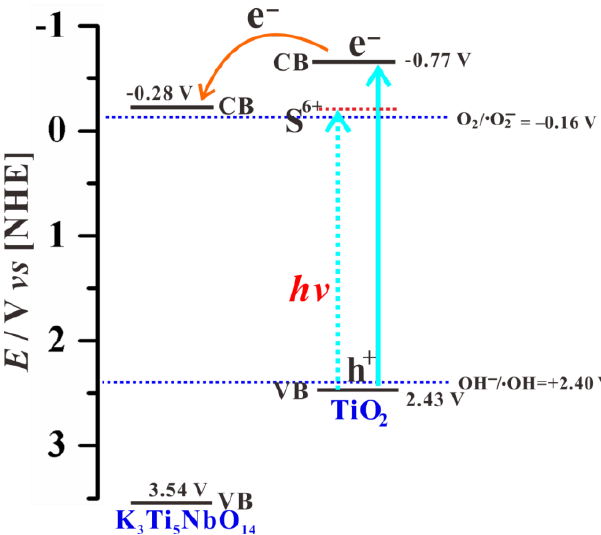
Figure 11. Energy levels of K 3 Ti 5 NbO 14 and anatase TiO 2 using a normal hydrogen electrode (NHE) as a reference at pH 7.